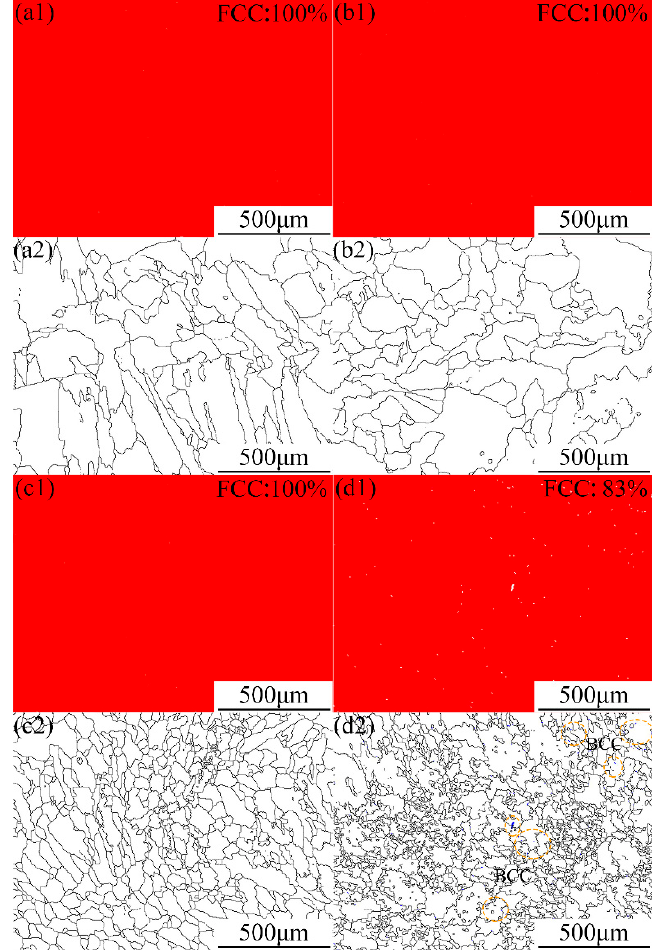
Figure 2. EBSD detection results of the FeCoCrNiMnAl x cladding layers: ( a1 ) x = 0, FCC (Face-Centered Cubic structure) phase (red zone); ( b1 ) x = 0.25, FCC phase; ( c1 ) x = 0.5, FCC phase; ( d1 ) x = 0.75, FCC phase; ( a2 ) x = 0, grain boundaries; ( b2 ) x = 0.25, grain boundaries; ( c2 ) x = 0.5, grain boundaries; ( d2 ) x = 0.75, grain boundaries and BCC phase (blue zone). Table 2. EDS detection results of dendritic and interdendritic spaces of FeCoCrNiMnAl x cladding layers